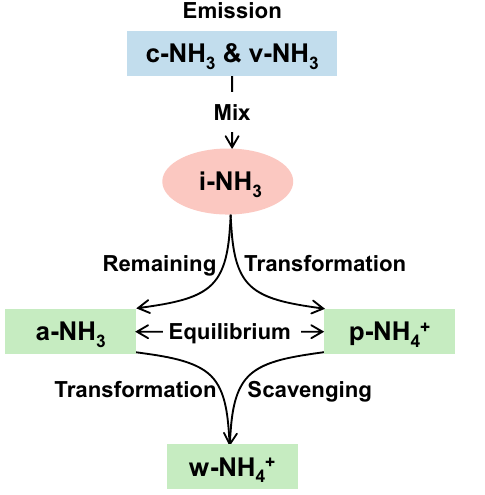
Fig. 1 | Conceptual framework of atmospheric NH 3 and NH 4 + . It shows the rela- tionships among NH 3 emissions from combustion-related sources (c-NH 3 ) and volatilization sources (v-NH 3 ), the initial mixture of c-NH 3 and v-NH 3 (i-NH 3 ), ambient NH 3 (a-NH 3 ), particulate NH 4 + (p-NH 4 + ), and precipitation NH 4 + (w-NH 4 + ). The a-NH 3 potentially includes the NH 3 that has not been converted to p-NH 4 + in earlier stages and the fresh NH 3 emissions in relatively later